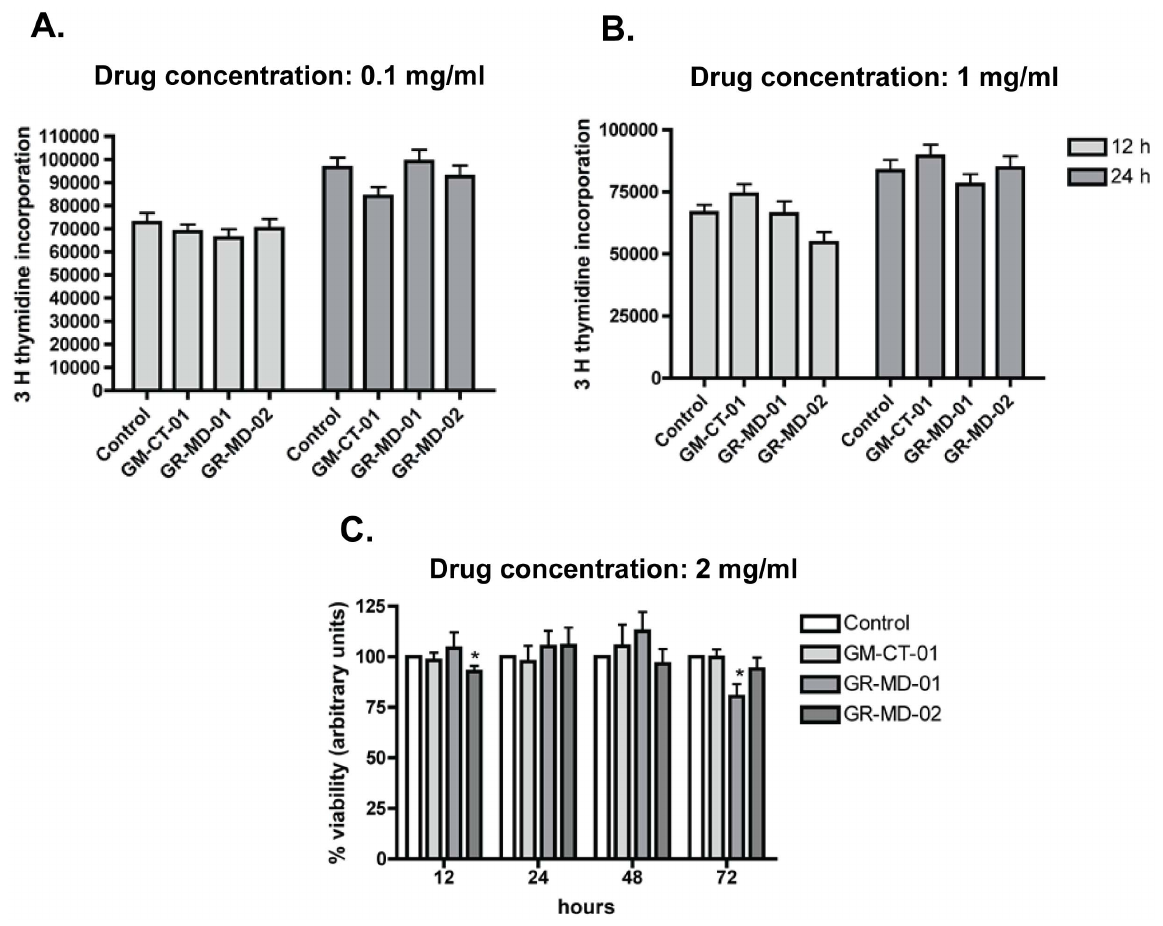
Figure 10. Evaluation of compound effects on growth and viability of LX-2 cells. A : thymidine incorporation at 12 and 24 hours of culture with drug compounds at a concentration of 0.1 mg/ml. B : thymidine incorporation at 12 and 24 hours of culture with drug compounds at a concentration of 1.0 mg/ml. C : cellular viability at 12, 24, 48, 72 hours of culture with drug compounds at a concentration of 2 mg/ml.